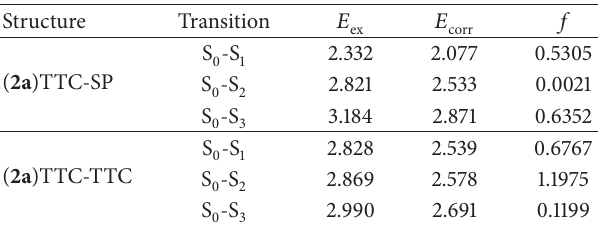
Figure 12: Electronic absorption spectra of bis-spiropyran ( 2b ) (acetonitrile solution) at the presence of different cations ( 𝑇 = 293 ∘ K, C ( 2b )) = 5.40 ⋅ 10 −5 M, C ( M ) = 4.0 ⋅ 10 −3 M. Table 4: Excitation energy 𝐸 (eV), corrected [17] excitation ex (eV) and oscillator strength 𝑓 of the first three singlet energy 𝐸 corr transitions of the merocyanine ( 2a )TTC-SP and ( 2a )TTC-TTC according to the TD DFT CPCM/PBE0/6-311G ∗∗ calculation in toluene